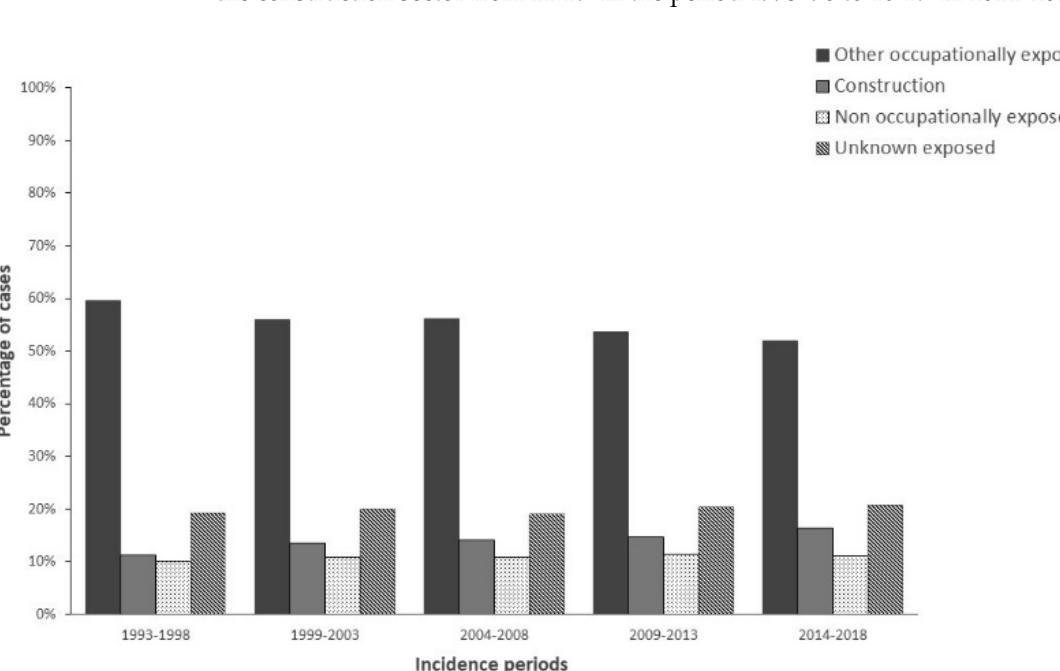
Figure 2. Distribution of MM cases (%) by exposed groups and time-period. Italy, ReNaM, 1993– 2018.